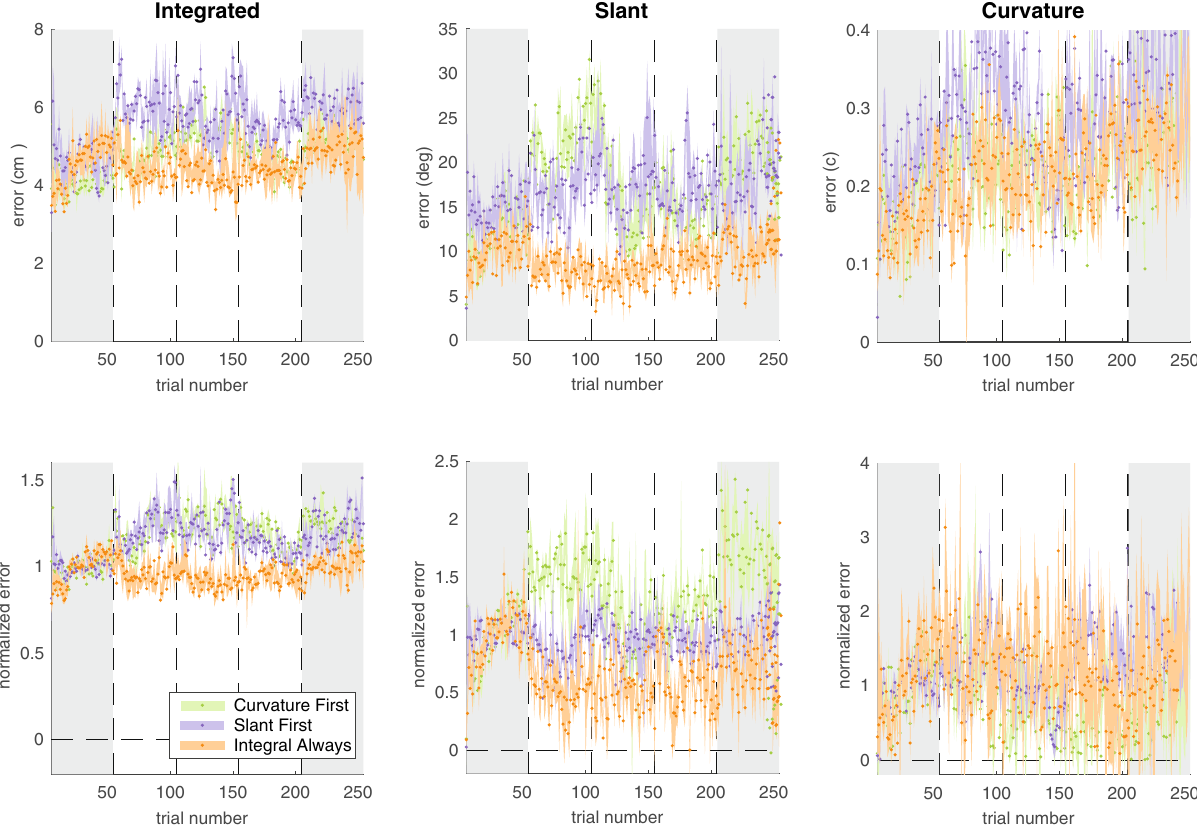
Figure 6. Median time course of errors across groups. Top row: absolute errors. Bottom row: normalized errors. Shaded errors represent the bootstrapped 95% confidence interval of the